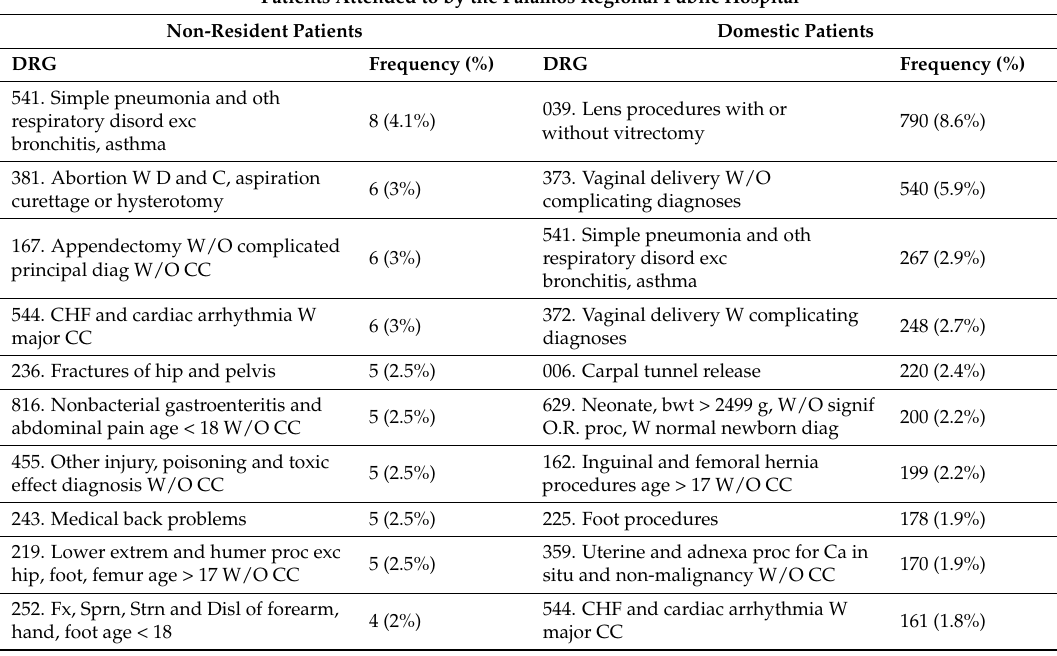
Table 2. The ten most frequent DRG for each